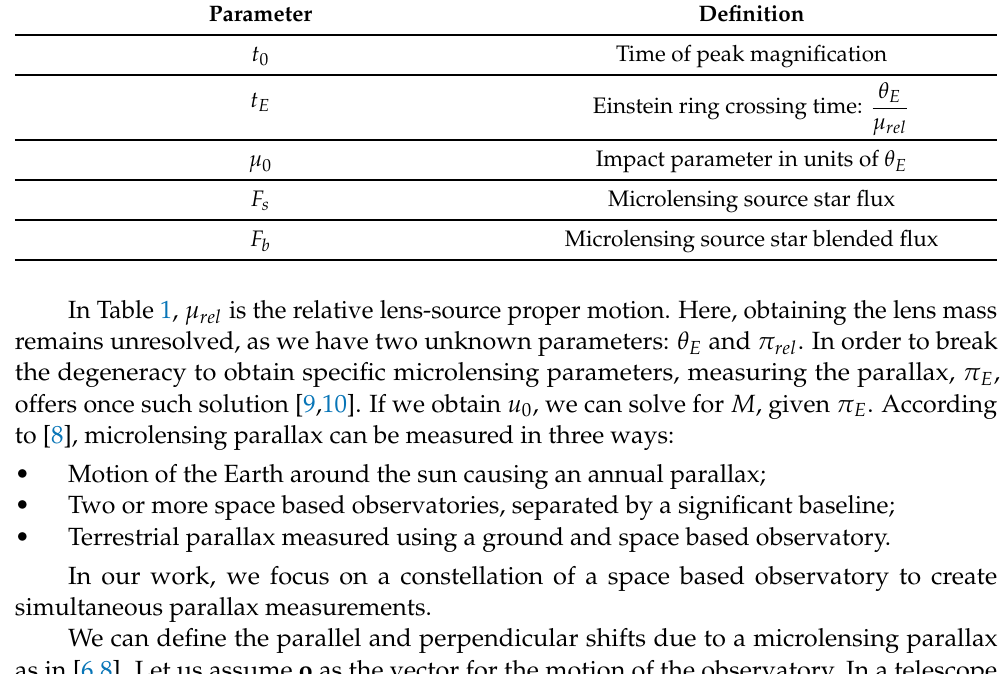
Table 1. Microlensing parameter definitions obtained from a photometric curve. Parameter